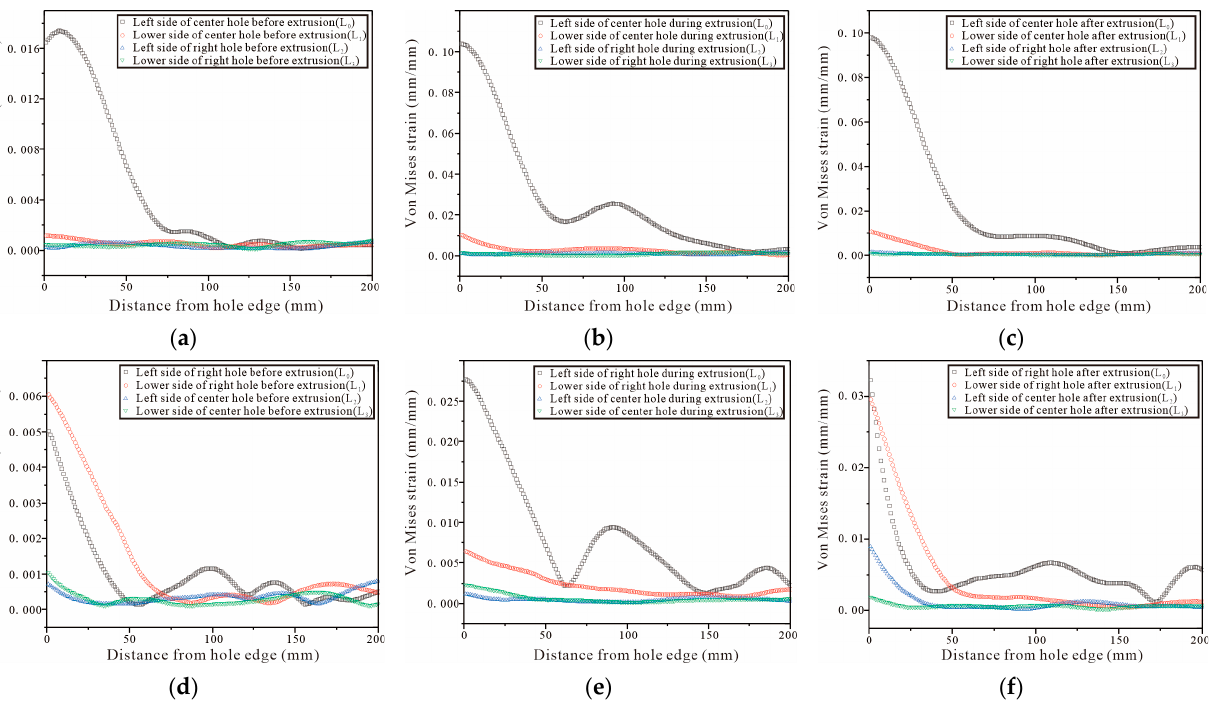
Figure 29. Von Mises strain results for the left and lower sides of the quadruple-pitch three-hole specimens (sequential SSCE): ( a – c ) strain distributions before, during, and after SSCE of the middle hole; ( d – f ) strain distributions before, during, and after SSCE of the right hole.